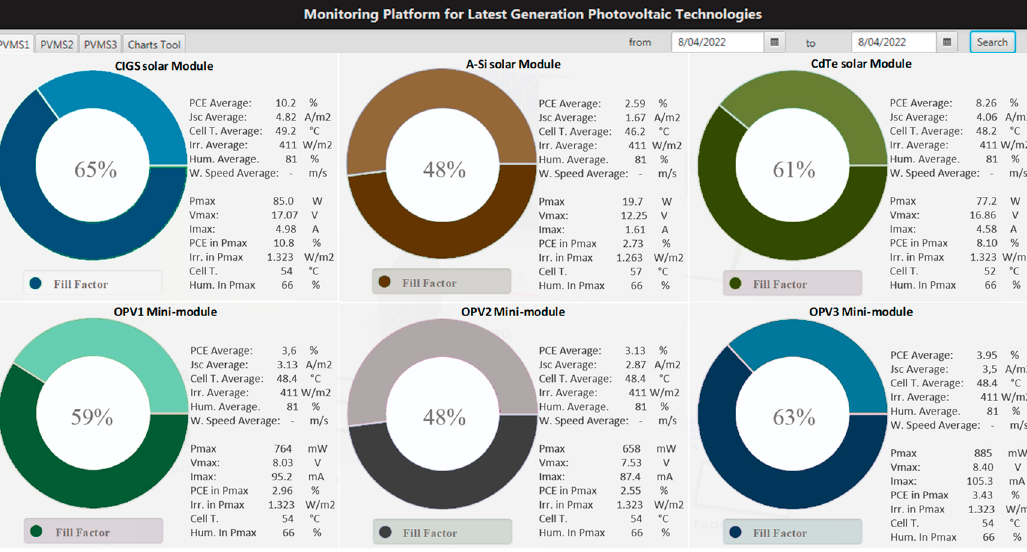
Figure 4. Data report window for outdoor performance analysis of PV technologies.